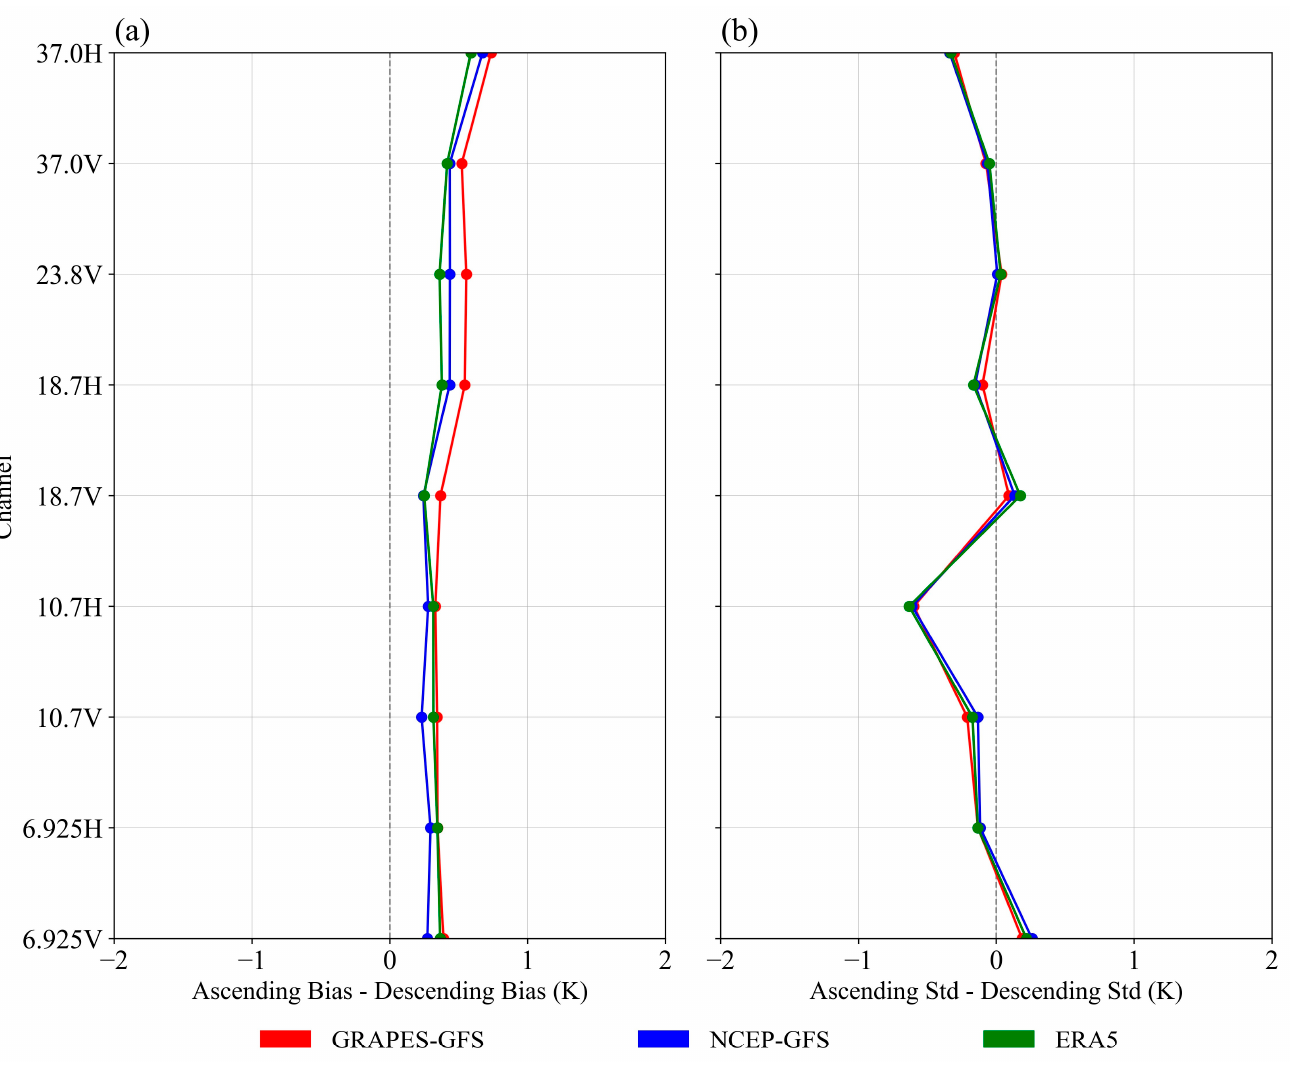
Figure 11. The HY-2B SMR ascending data statistics minus equivalent statistics for descending data: ( a ) the AD biases for all channels; ( b ) the AD standard deviations for all channels. Statistics are from 10 July 2021 to 10 August 2021 after applying the QC procedure described in Section 2.4. The green line represents the O-B statistics based on ERA5, the blue line represents the O-B statistics based on NCEP-GFS, and the red line represents the O-B statistics based on GRAPES-GFS.